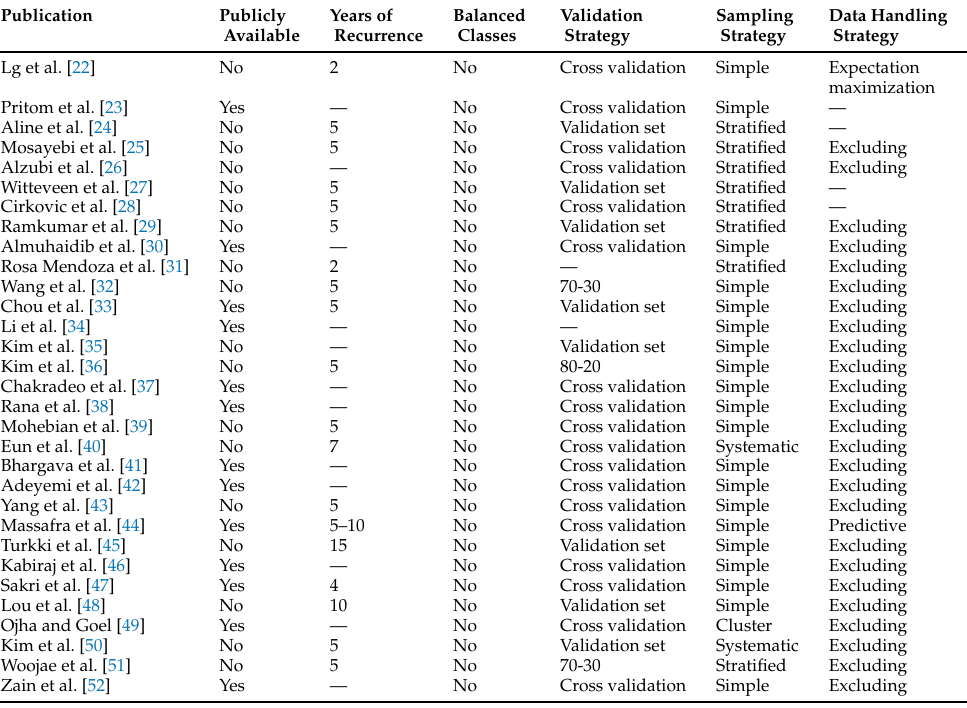
Table 6. Training and testing methodologies. Excluding = excluding uncompleted data; predictive = predictive value